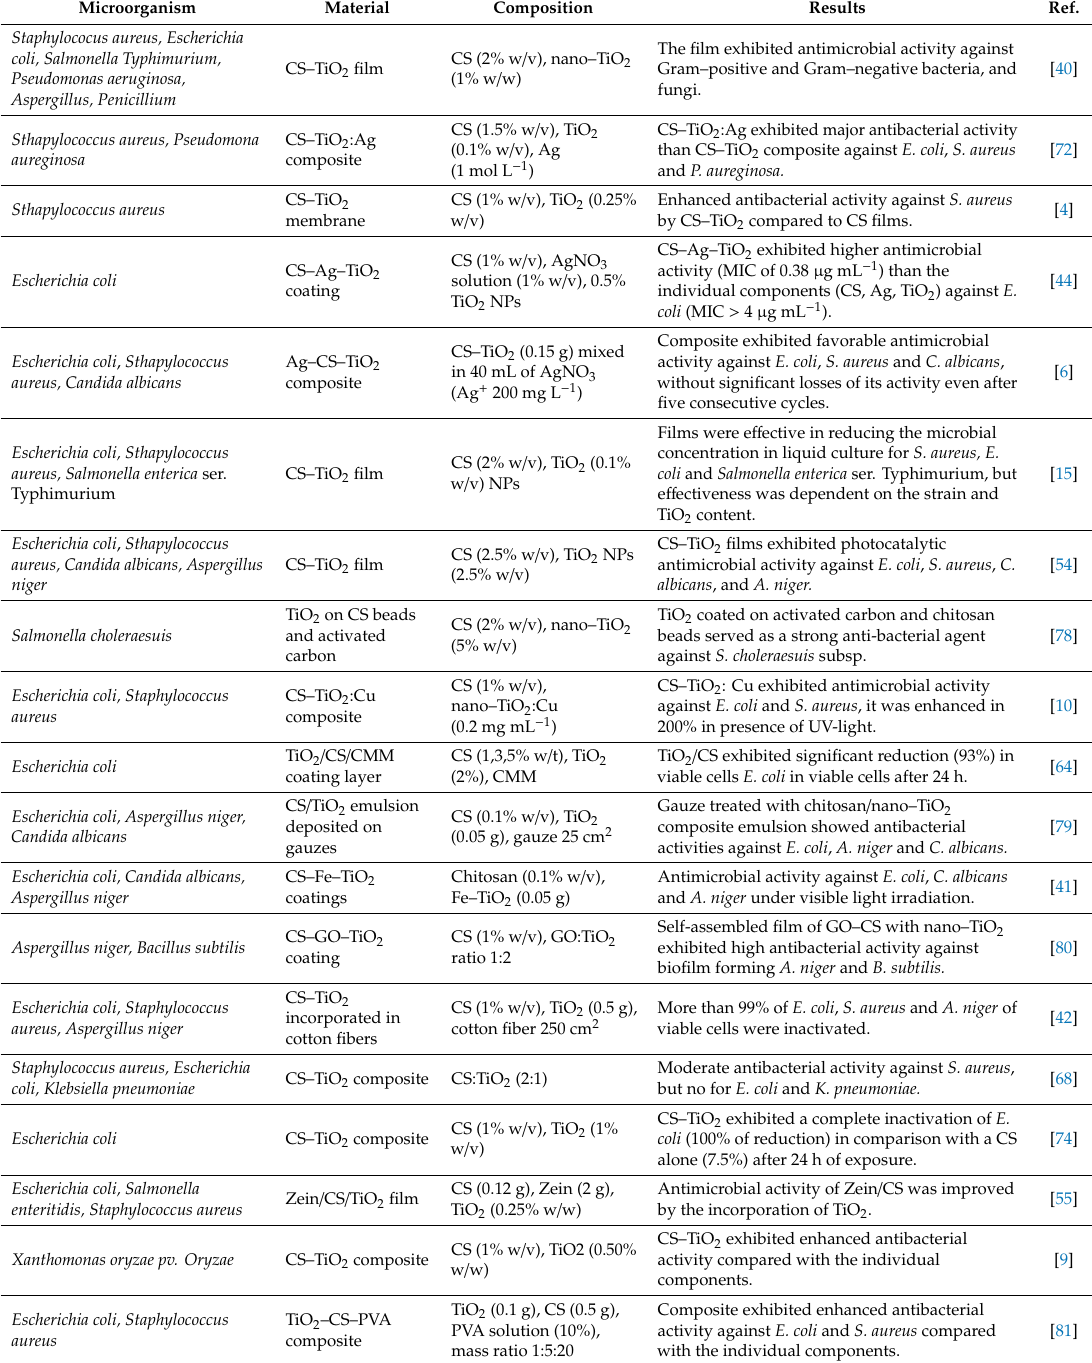
Table 4. Antimicrobial activity of CS–TiO 2